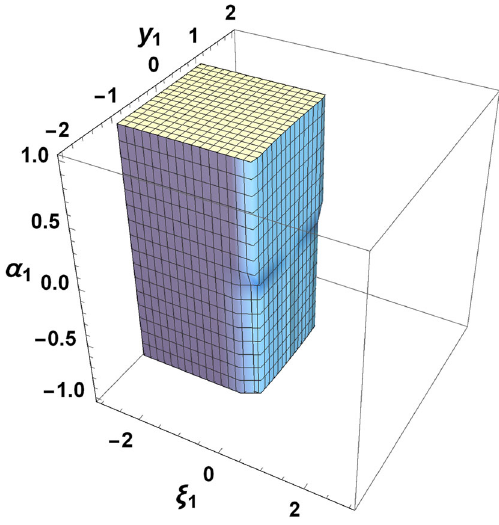
Fig. 3 The non-exclusive saddle regions where the P 3 critical line rep- resents a saddle cosmological epoch ( E P